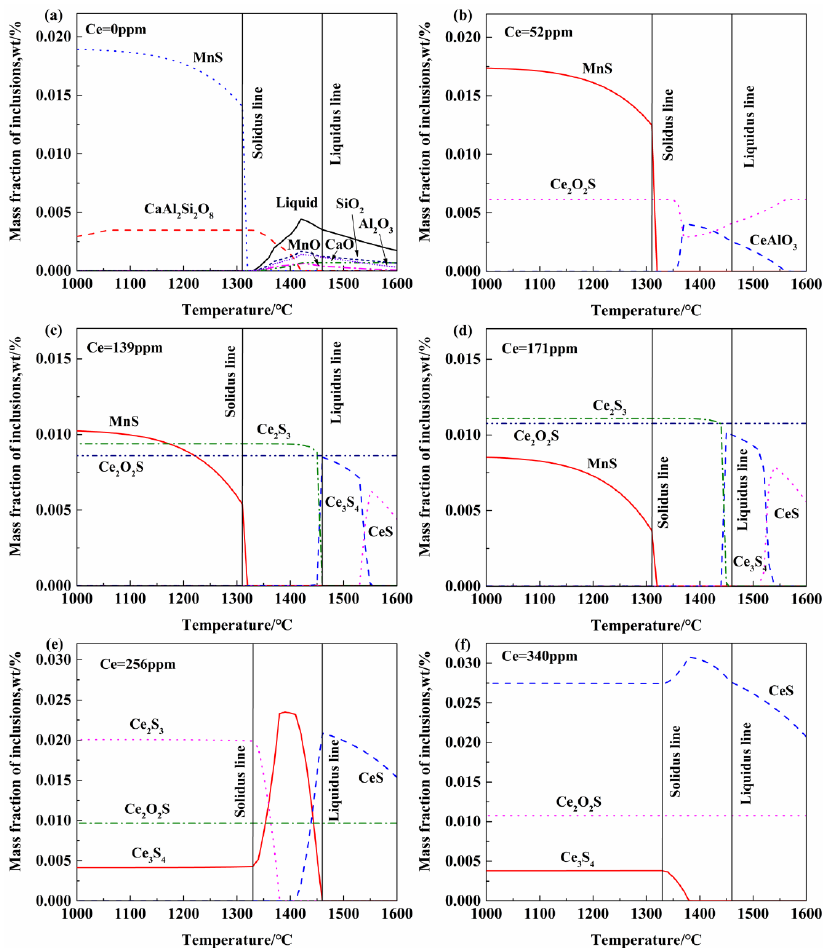
Figure 9. Evolution of inclusions during solidification with different Ce contents: ( a ) 0 ppm, ( b ) 52 ppm, ( c ) 139 ppm, ( d ) 171 ppm, ( e ) 256 ppm, ( f ) 340 ppm.